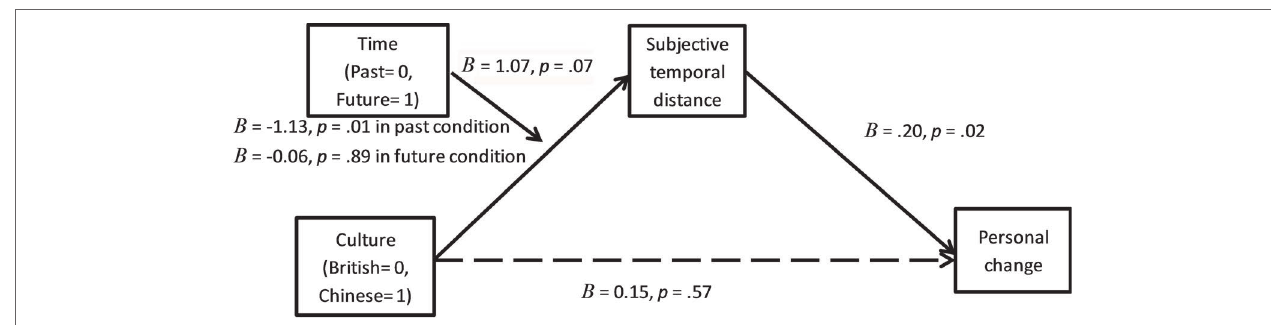
FIGURE 7 | Time condition moderated the effect of culture on subjective temporal distance, which positively predicted personal change.